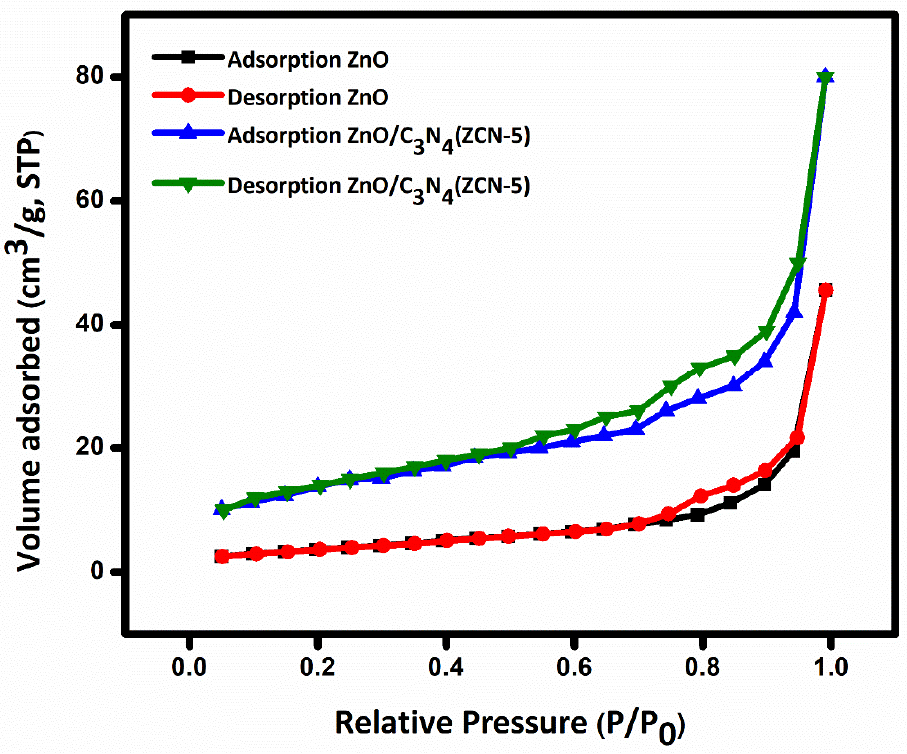
Figure 7. N 2 adsorption–desorption isotherms of ZnO/C 3 N 4 (ZCN-5) and ZnO.